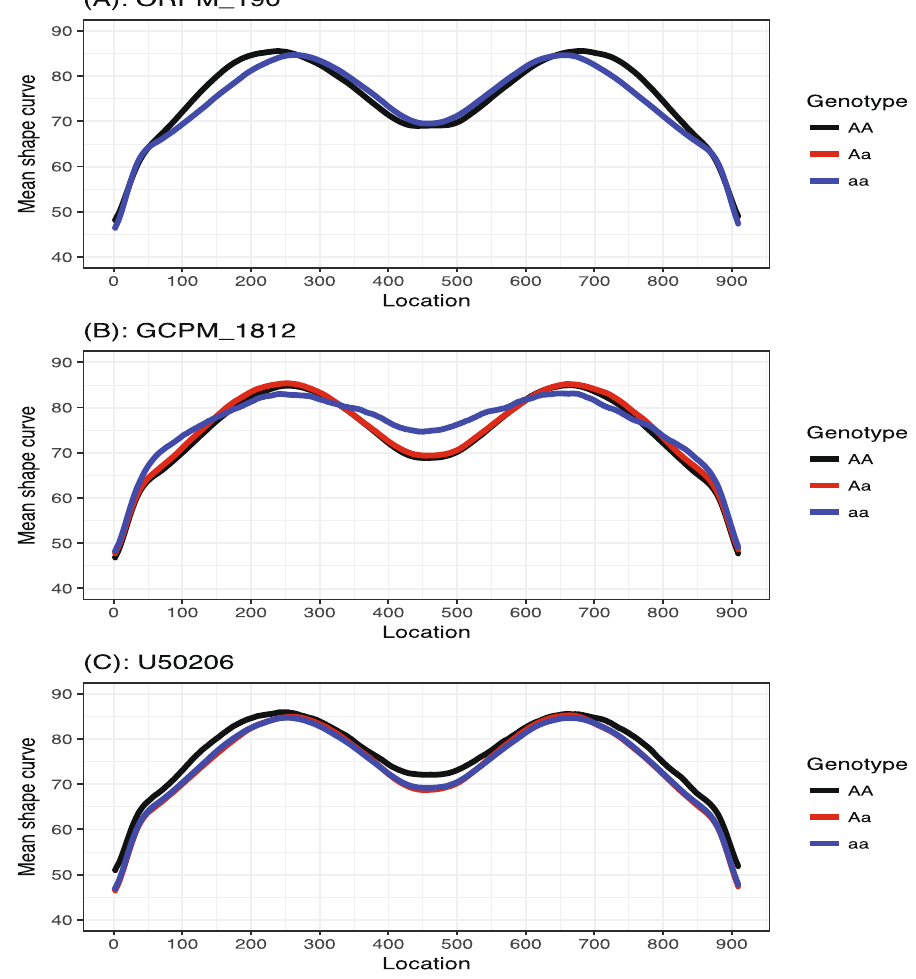
Figure 6. The average of the predicted shape curves output from the FunFor approach across all observations belong to each genotype category for the top three most important markers ORPM_190 , GCPM_1812 , and U50206 . The black curve for AA, the red curve for Aa, and the blue curve for